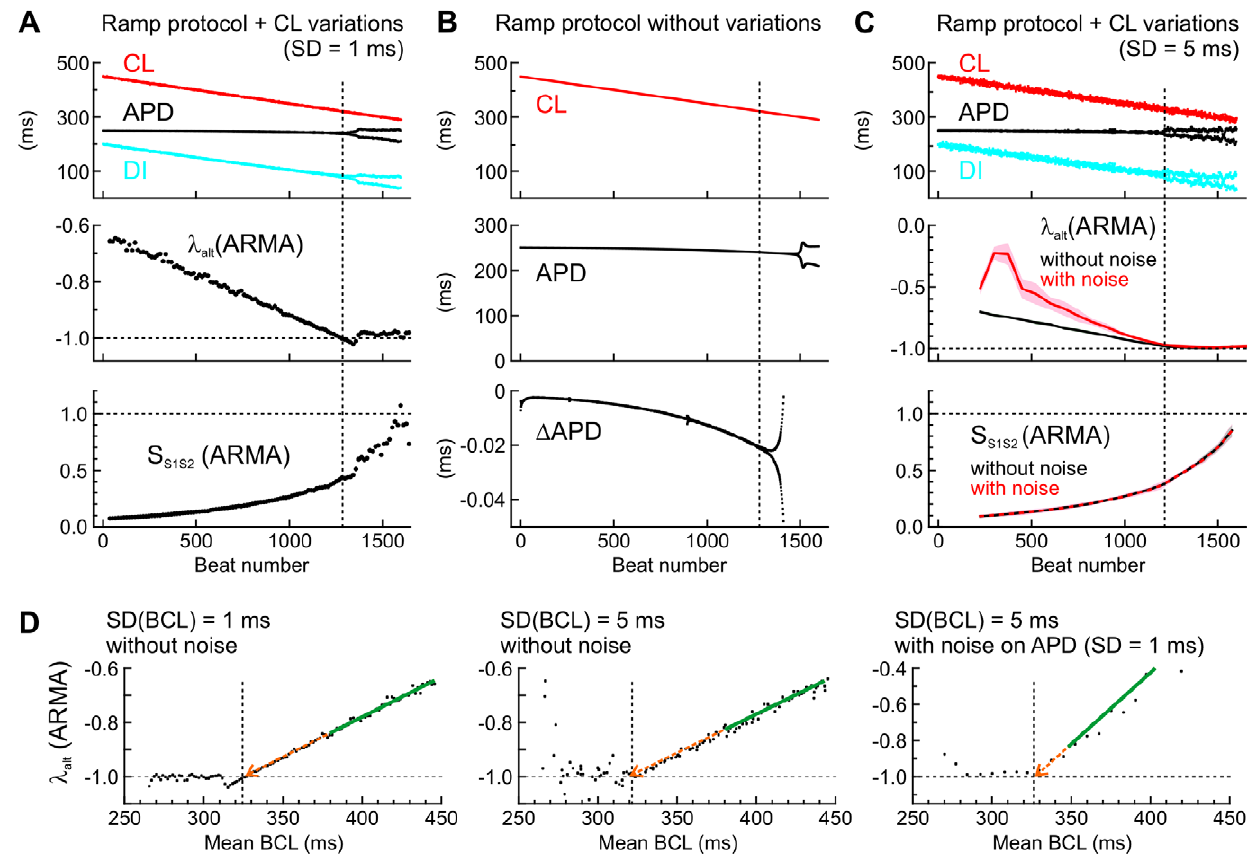
Figure 6. Predicting alternans in the Ca 2 + -driven model with positive Ca 2 + to APD coupling during ramp pacing. A : CL, APD, DI, l alt and S S1S2 during the ramp decrease of CL with superimposed variations (SD=1 ms). l alt and S S1S2 were estimated every 15 beats using a 2 nd order ARMA model from APDs and CLs in a window spanning the 30 preceding cycles. B : CL, APD and the difference series of APD ( D APD=APD i – APD i 2 1 ) during the ramp decrease of CL without stochastic variations. C : Top : CL, APD and DI during the ramp decrease of BCL with superimposed CL variations (SD=5 ms). Middle and bottom : Analysis of l alt and S S1S2 in n =10 simulations, with and without adding a Gaussian error (SD=1 ms) to APD, simulating experimental measurement error. l alt and S S1S2 were estimated every 75 beats using a 2 nd order ARMA model from APDs and CLs in a window spanning the 150 preceding cycles. Data are presented as mean (bold lines) 6 SD (shaded areas). In all panels, vertical dotted lines indicate the onset of macroscopic alternans (in A and C ) and of micro-alternans (in B ). D : Prediction of alternans by analyzing l alt vs. mean BCL in the windows in which l alt was evaluated. Left : using a SD of BCL of 1 ms (windows of 30 cycles). Middle : using a SD of BCL of 5 ms (windows of 30 cycles). Right : using a SD of BCL of 5 ms, after adding a Gaussian error on APD (SD=1 ms; windows of 150 cycles). The green lines represent linear regression on data points with l alt .2 0.85, and the dotted orange arrows represent the extrapolation of these regression lines towards l alt = 2 1. The occurrence of alternans is marked with vertical dotted